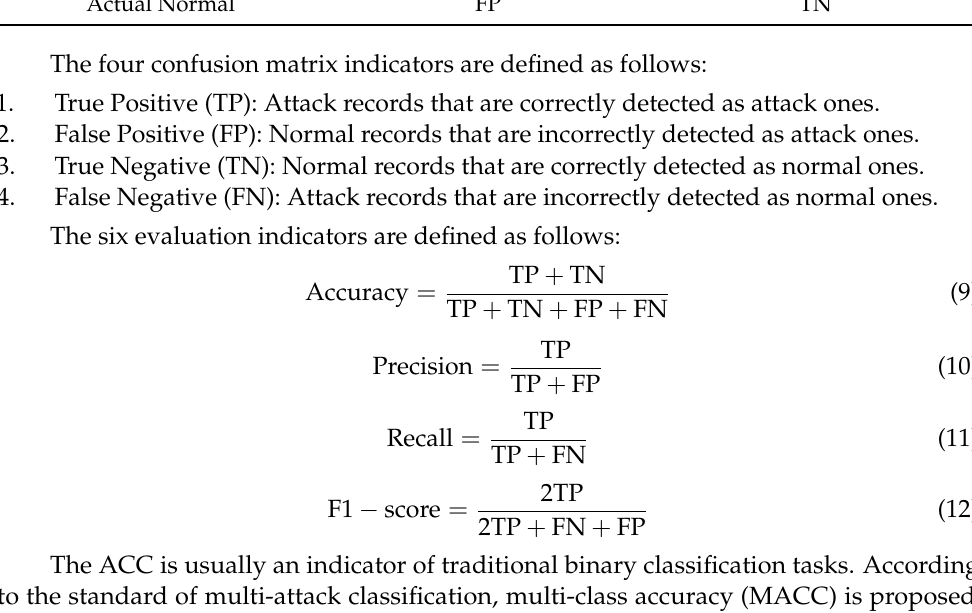
Figure 7. DSN model structure settings.